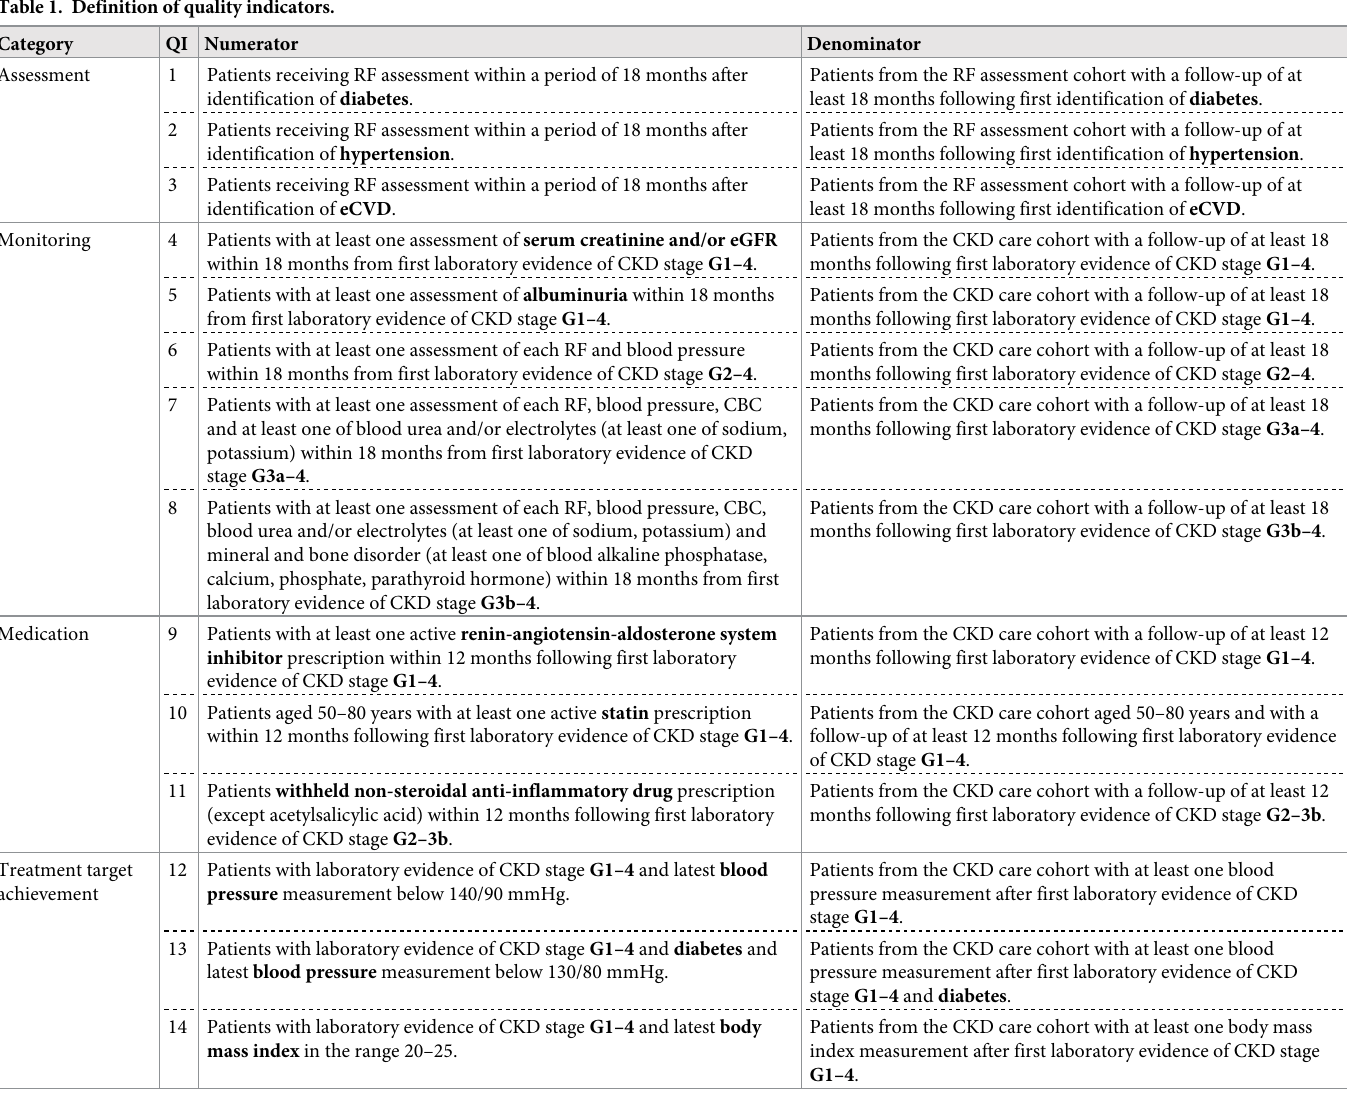
patient and GP demographics, and urbanity of practice location (according to the Swiss Fed- eral Statistical Office [29]). GP-level random intercepts were used to account for clustering of patients within their respective GPs. We report fixed-effect summaries of regression models in terms of odds ratios (OR) with corresponding 95% confidence intervals (CI) and display them graphically as forest plots. GP-level variation of QI achievement rates is summarised in terms of intraclass correlation coefficients (ICCs, [30]) and of range odds ratios (rOR) across the central 90% of fitted ran- dom intercepts. Both were determined in analogous mixed-effect models under omission of GP-level fixed effects, where the influence of individual GPs was entirely expressed by the